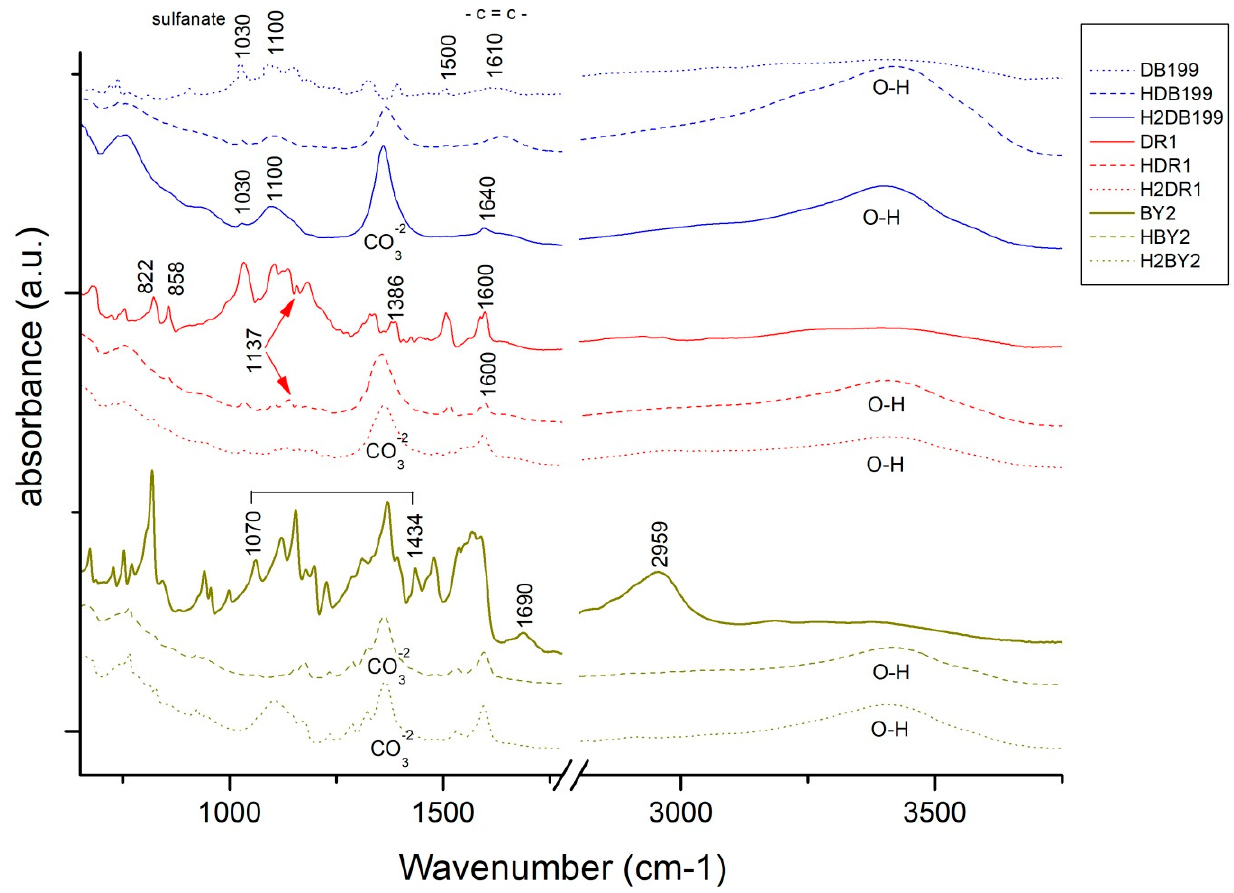
Figure 4. FTIR comparison of Uncalcined Hydrotalcite (H) and Calcined Hydrotalcite (HC).